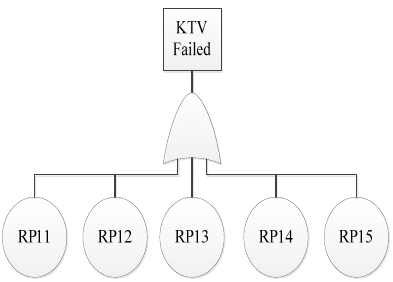
Figure 4. Configuration reliability event tree model.